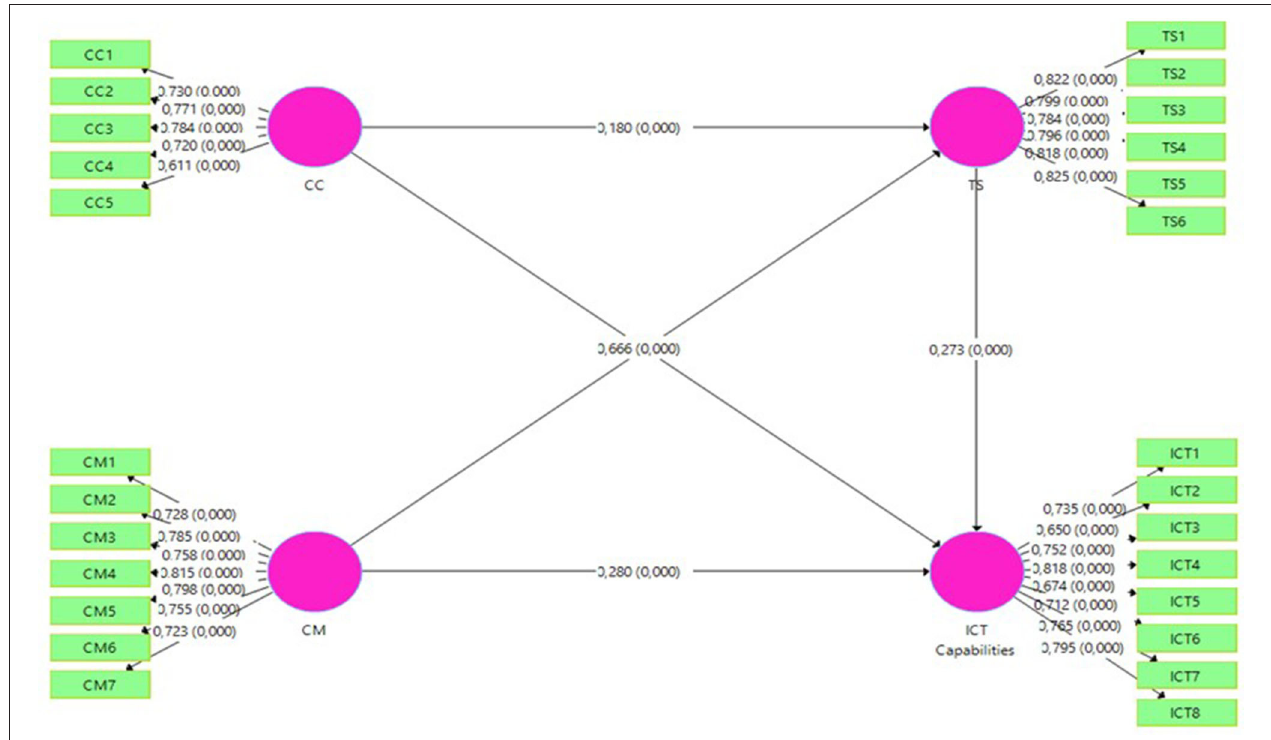
FIGURE 2 | The theoretical constructs with R 2